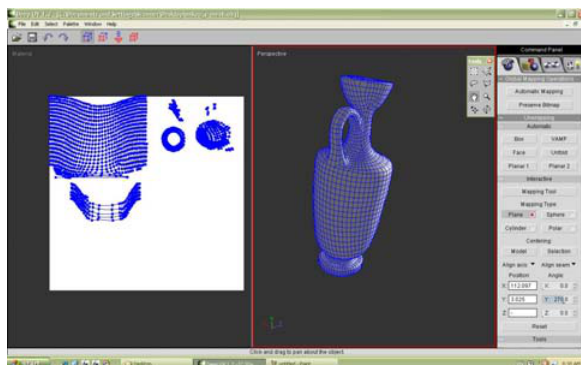
Fig the . 8. Manually selected parts of the surface for incremental creation of the 2D texture map The next step is to provide the texture map with the right colours. For this procedure, the georeferenced meshes and the image of each scan and the constrained mesh were inserted in the 3D Studio Max software by Autodesk ® . Τ he result is a texture map with colour, containing the information from the each scan. This step results in many texture maps; the number of texture maps equals the number of individual scans, acquired during the field work. However, for the texture of the final Fig. 6. Creation of the c-mesh surface surface, only one texture map must be used. Thus, all the individual texture maps are composed and turned into the final texture map using the Photoshop CS5 ® software (Fig.